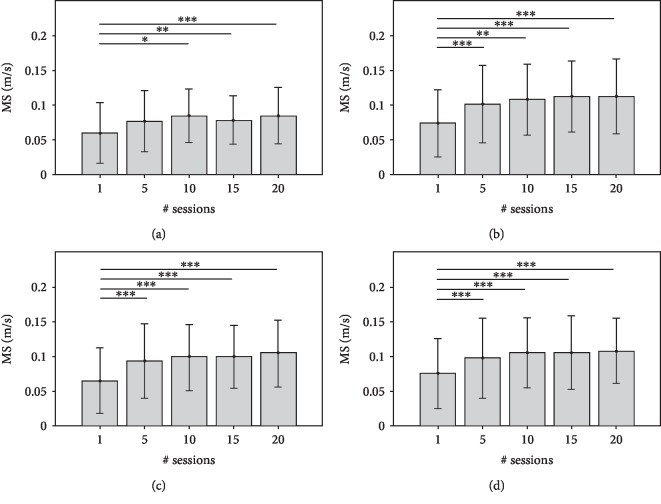
MS values (mean and standard deviation) at 1st, 5th, 10th, 15th, and 20th sessions of RT and significant post hoc comparisons between sessions (Conover's test): ∗p value < 0.05; ∗∗p value < 0.001; ∗∗∗p value < 0.0001. The data obtained by analysing the end-effector trajectories towards the four targets (A, B, C, D) are showed separately.